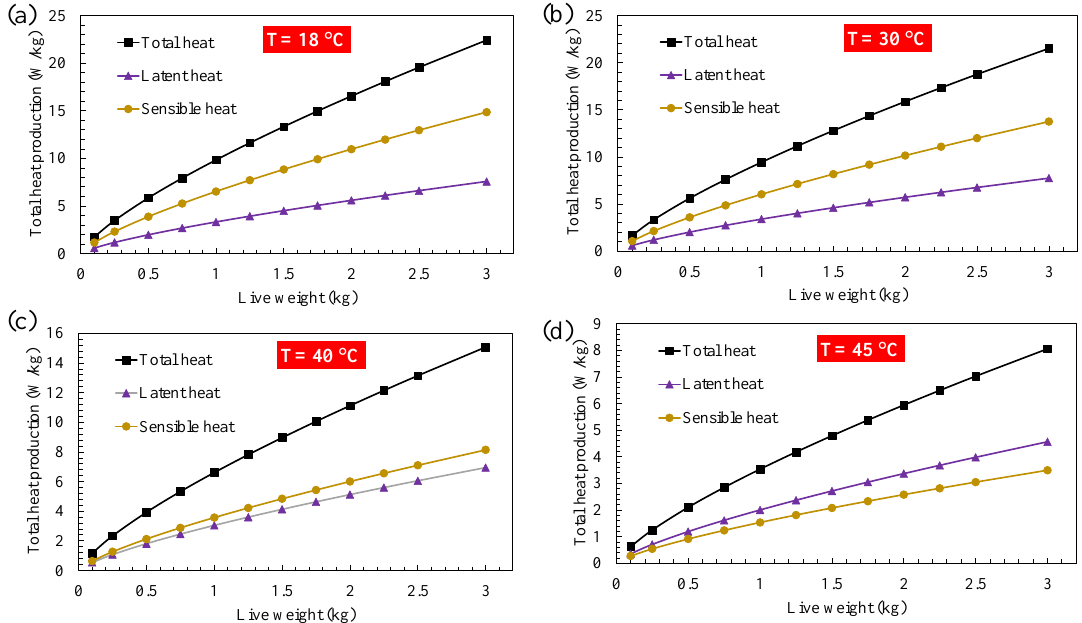
Figure 11. The numerical values of THI corresponding to various temperature and relative humidity levels. The green color presents relatively better THI whereas a red color reflects the worst scenario of THI.